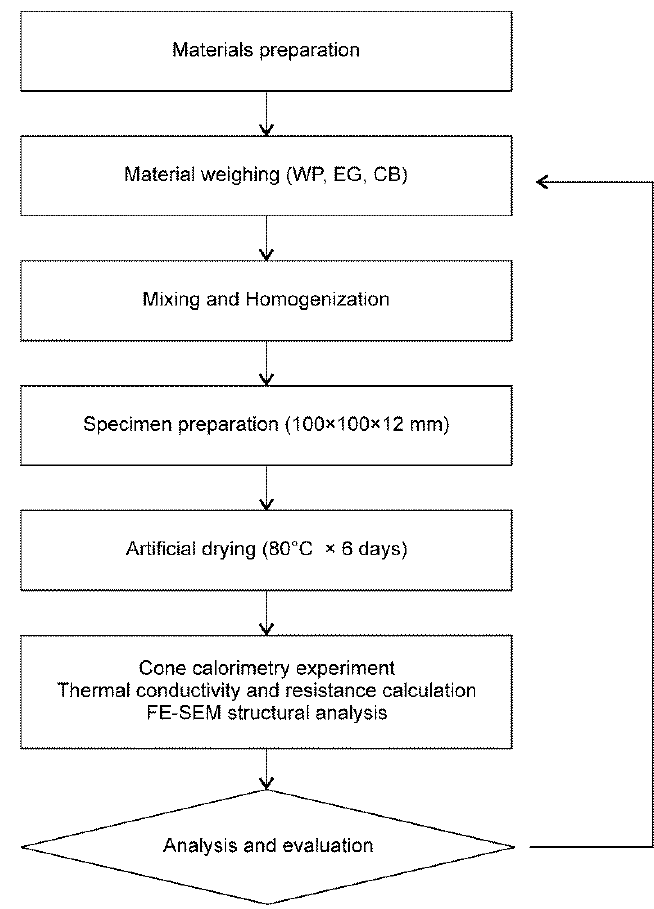
Chart 1. Flowchart of experimental sequence.